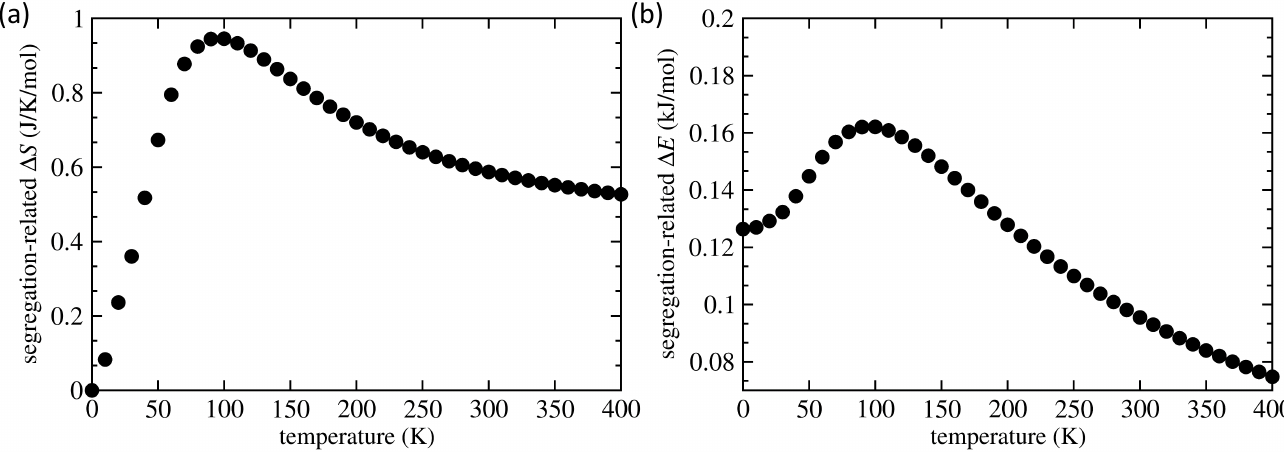
Figure 7. Computed entropy difference ∆ S ( a ) and phonon energy difference ∆ E ( b ) (both per 64-atom supercell) between the states with Cu at the APB interfaces and far away from them.